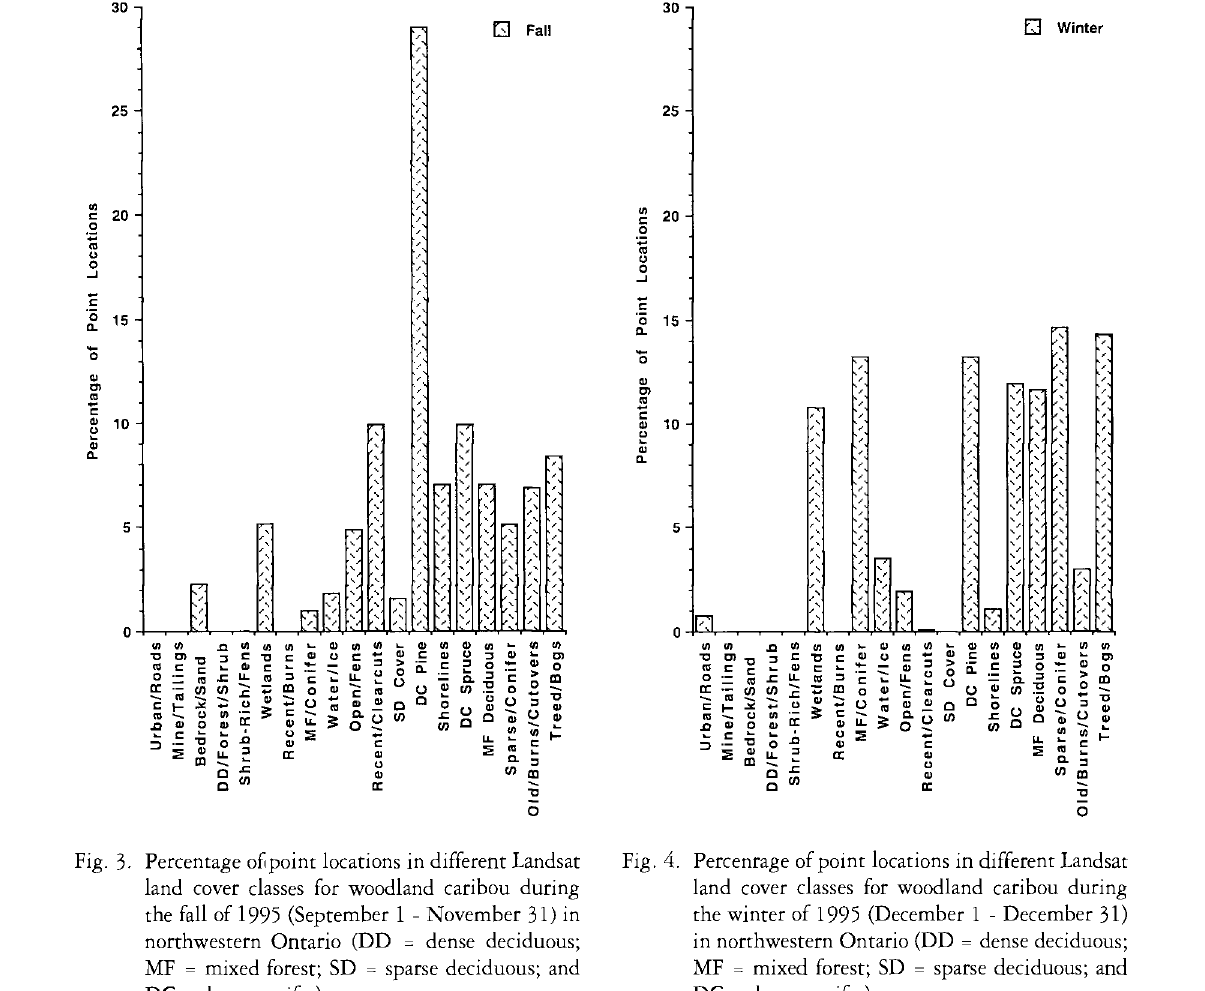
Fig. 4. Percenrage of point locations in different Landsat land cover classes for woodland caribou during the winter of 1995 (December 1 - December 31) in northwestern Ontario (DD = dense deciduous; MF = mixed forest; SD = sparse deciduous; and DC = dense